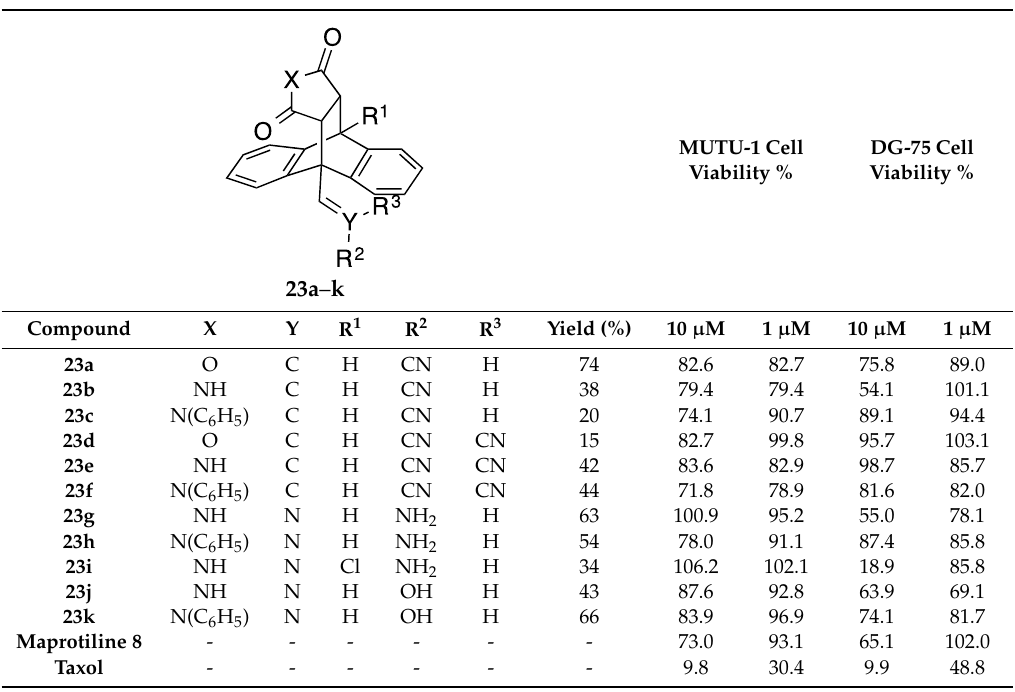
Table 9. Yields and preliminary cell viability data for compounds 23a – k (Series VII) in MUTU-1 and DG-75 Burkitt lymphoma cell lines a .